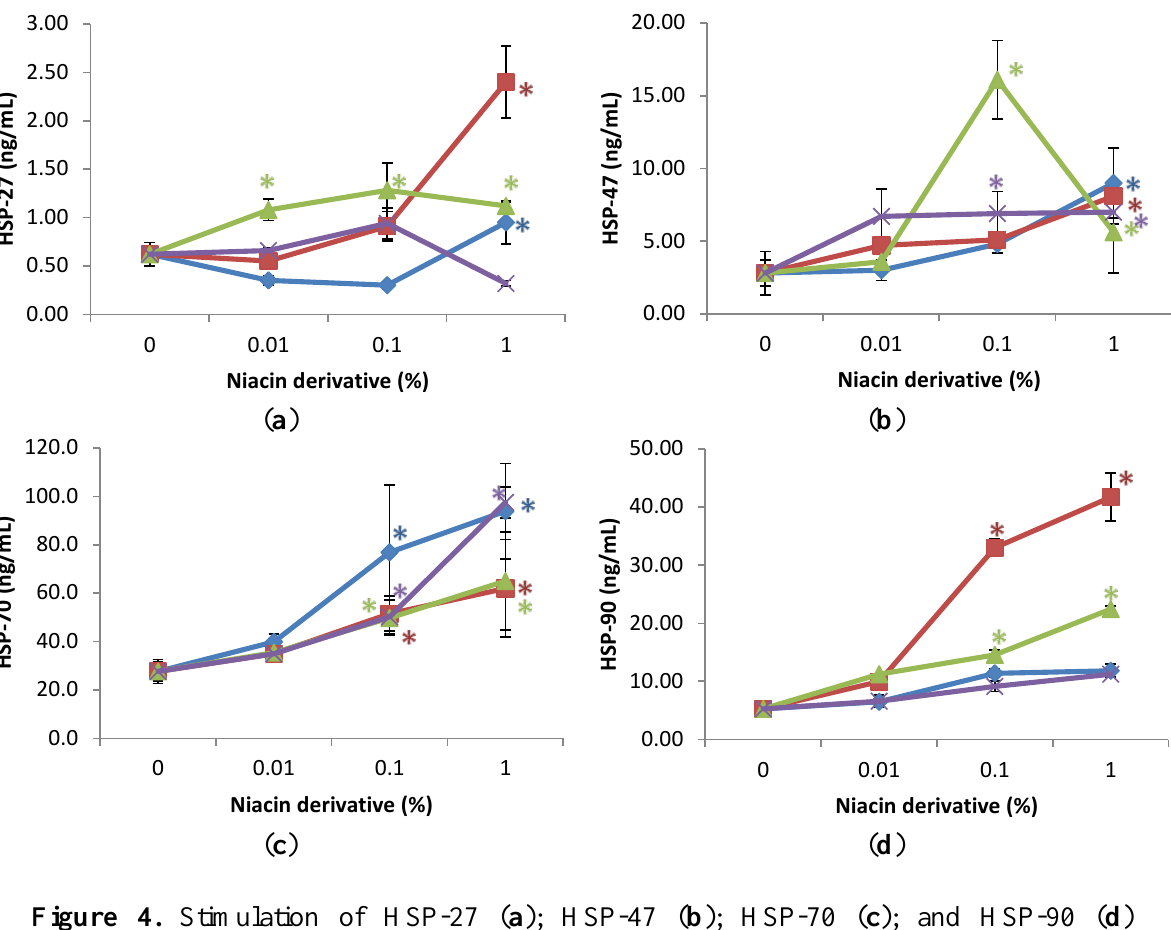
Figure 4. Stimulation of HSP-27 ( a ); HSP-47 ( b ); HSP-70 ( c ); and HSP-90 ( d ) proteins by nicotinamide (green line), 2,6-dihydroxynicotinamide (red line), 2,4,5,6-tetrahydroxynicotinamide (violet line), and 3-hydroxypicolinamide (blue line) in UVA-radiated dermal fibroblasts; * p < 0.05, relative to UVA radiated control cells, error bars ( a – d ) represent standard deviation, n =